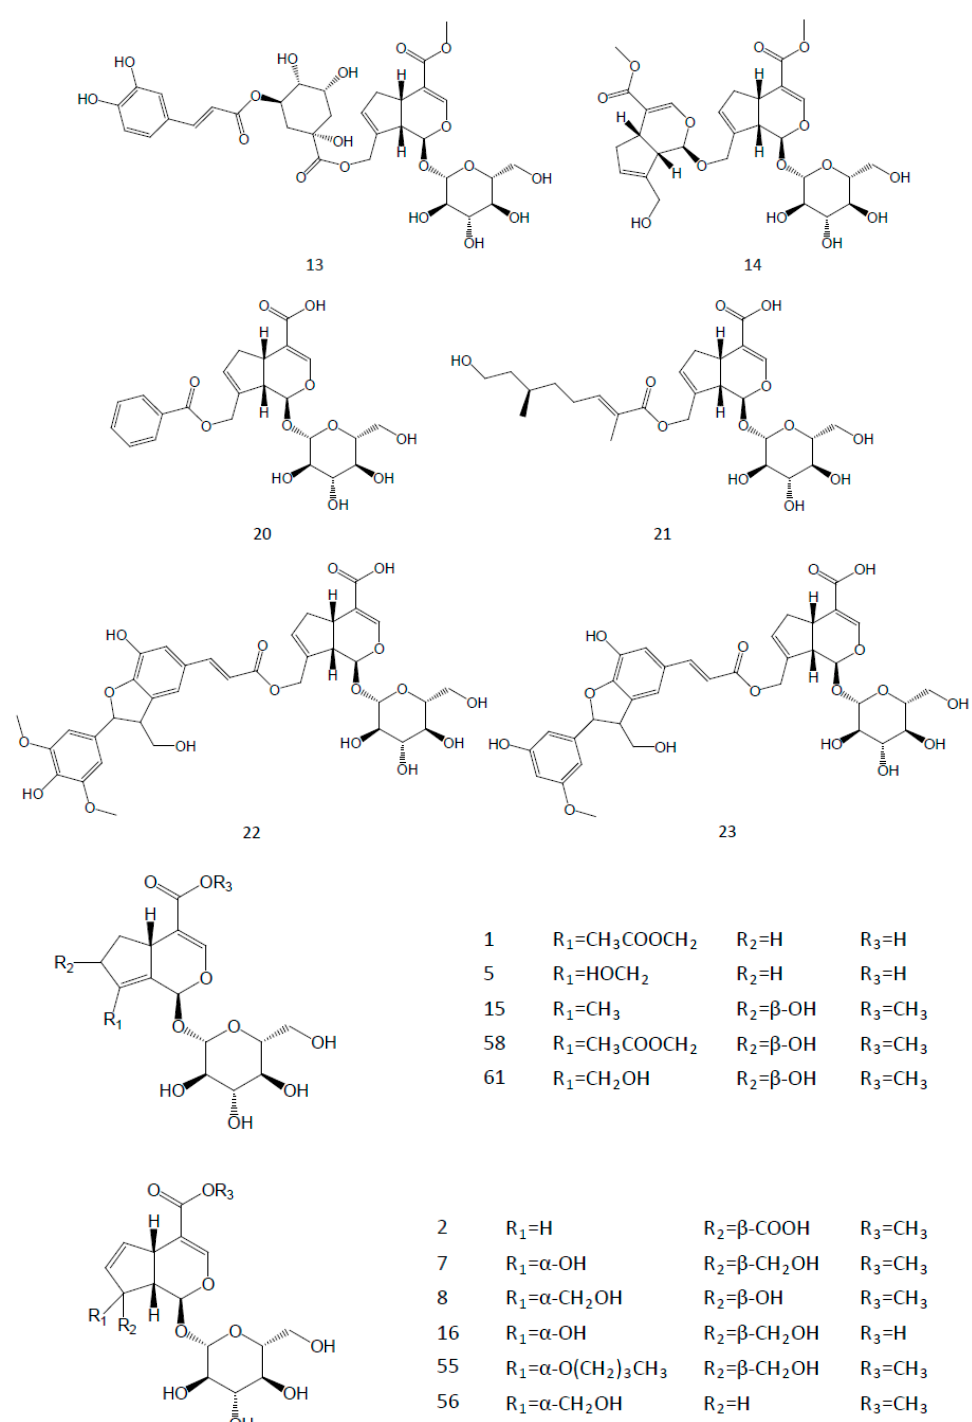
Figure 2. Chemical structures of some representative geniposide derivatives.